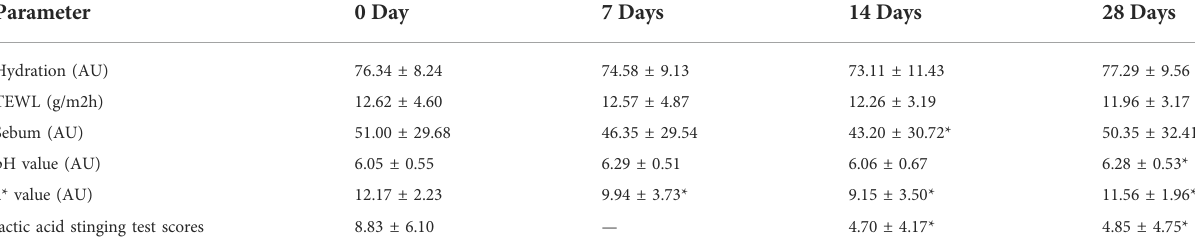
TABLE 1 TEWL, hydration, sebum, pH, a* value, and lactic acid stinging test scores on 0,7, 14, and 28 days after the use of the product (mean ±